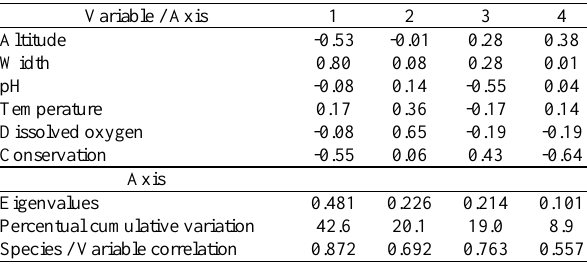
Table 3. Results of Canonical Correspondence Analyses (CCA) of fish abundance and environmental